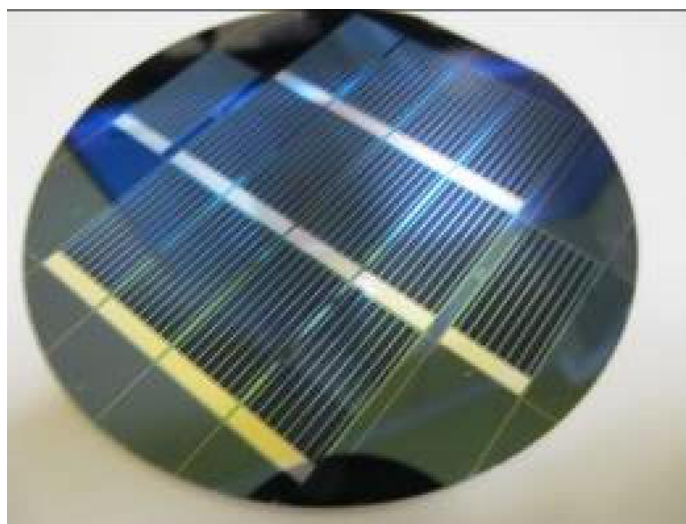
Figure 4. Appl. Sci. 2021 , 11 , x FOR PEER REVIEW